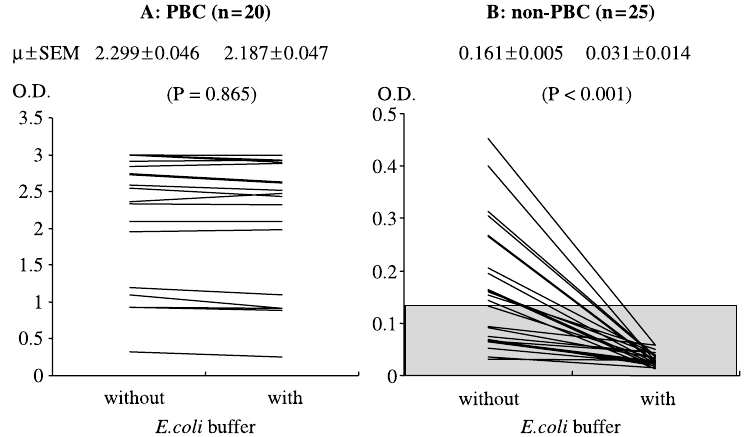
Figure 5. Comparison of OD values with and without our unique E. coli buffer for AMA–ELISA using the triple hybrid antigen pMIT3. Mean OD values were not different with the buffer for PBC sera ( n ¼ 20) while they were significantly lower when the buffer was used for non- PBC sera ( n ¼ 25). The OD threshold value (0.130) is represented in the right